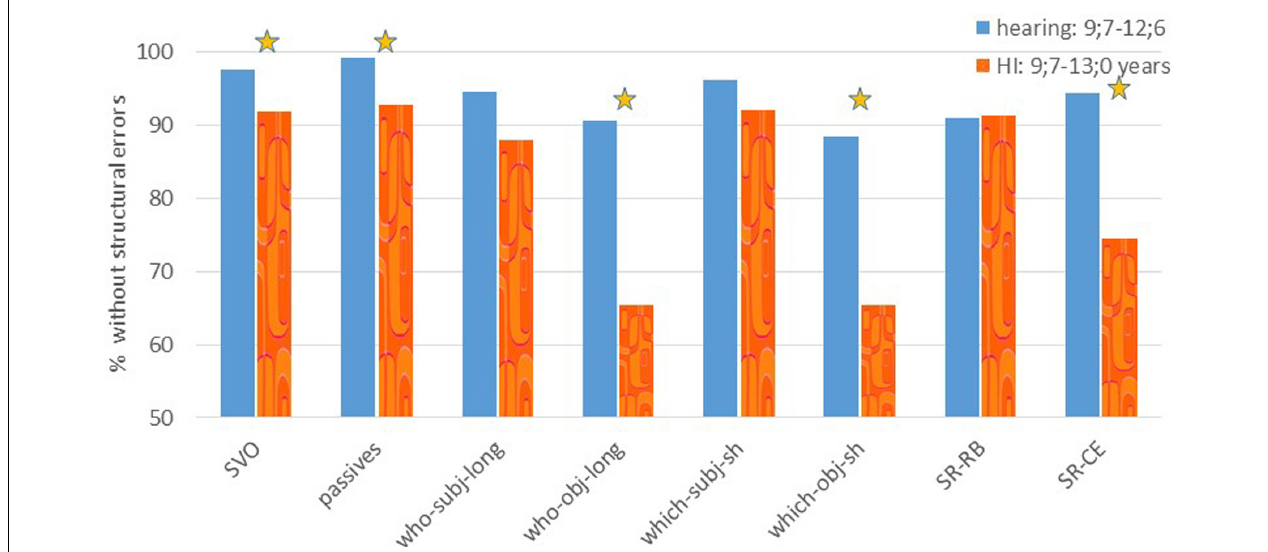
FIGURE 5 | Experiment 3: % of sentences repeated without structural errors. SVO, passives, long subject and object who questions, short subject and object which questions, SR-RB: right-branching subject relatives and SR-CE: center embedded subject relatives. A star indicates a significant difference between the groups.